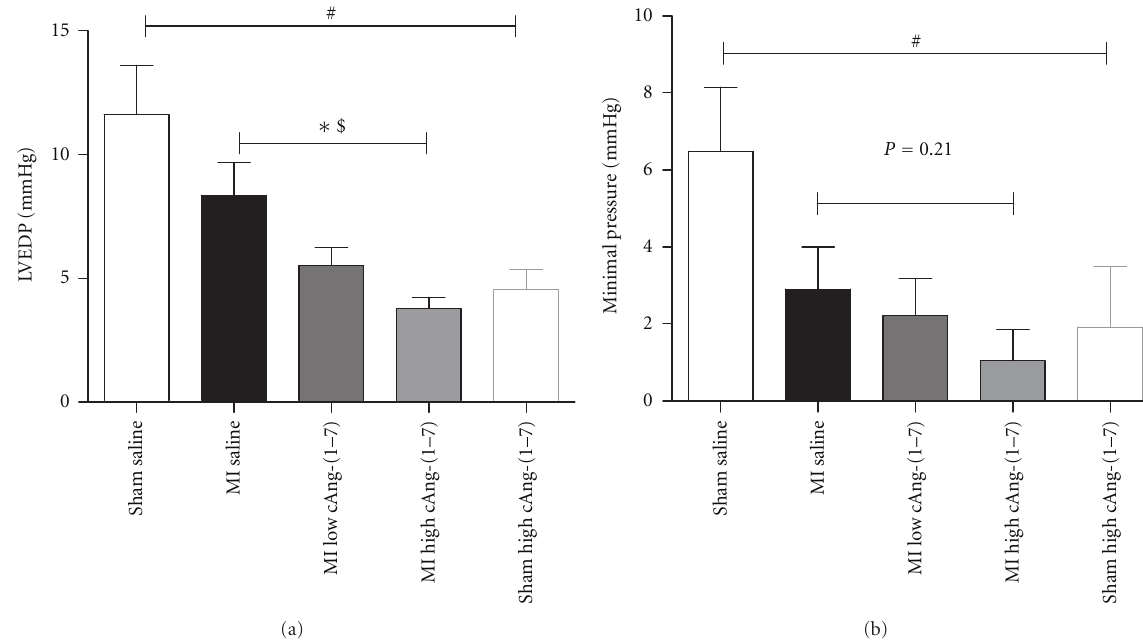
Figure 2: E ff ects of cAng 1–7 on left ventricular end-diastolic pressure and minimal pressure in both sham-operated rats and rats with myocardial infarction. ( # P < 0 . 05 t -test sham saline versus sham cAng-(1–7); ∗ P < 0 . 05, One way ANOVA for MI groups, Dunnett’s post hoc testing; $ P < 0 . 05 for linear trend for MI